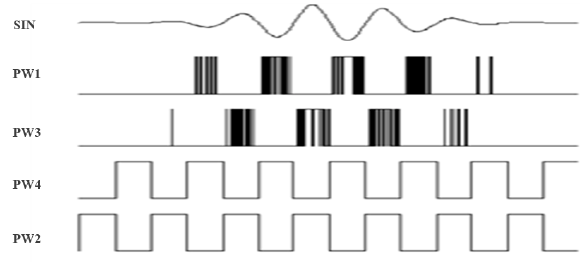
Figure 7. Working sequence chart of SPWM.